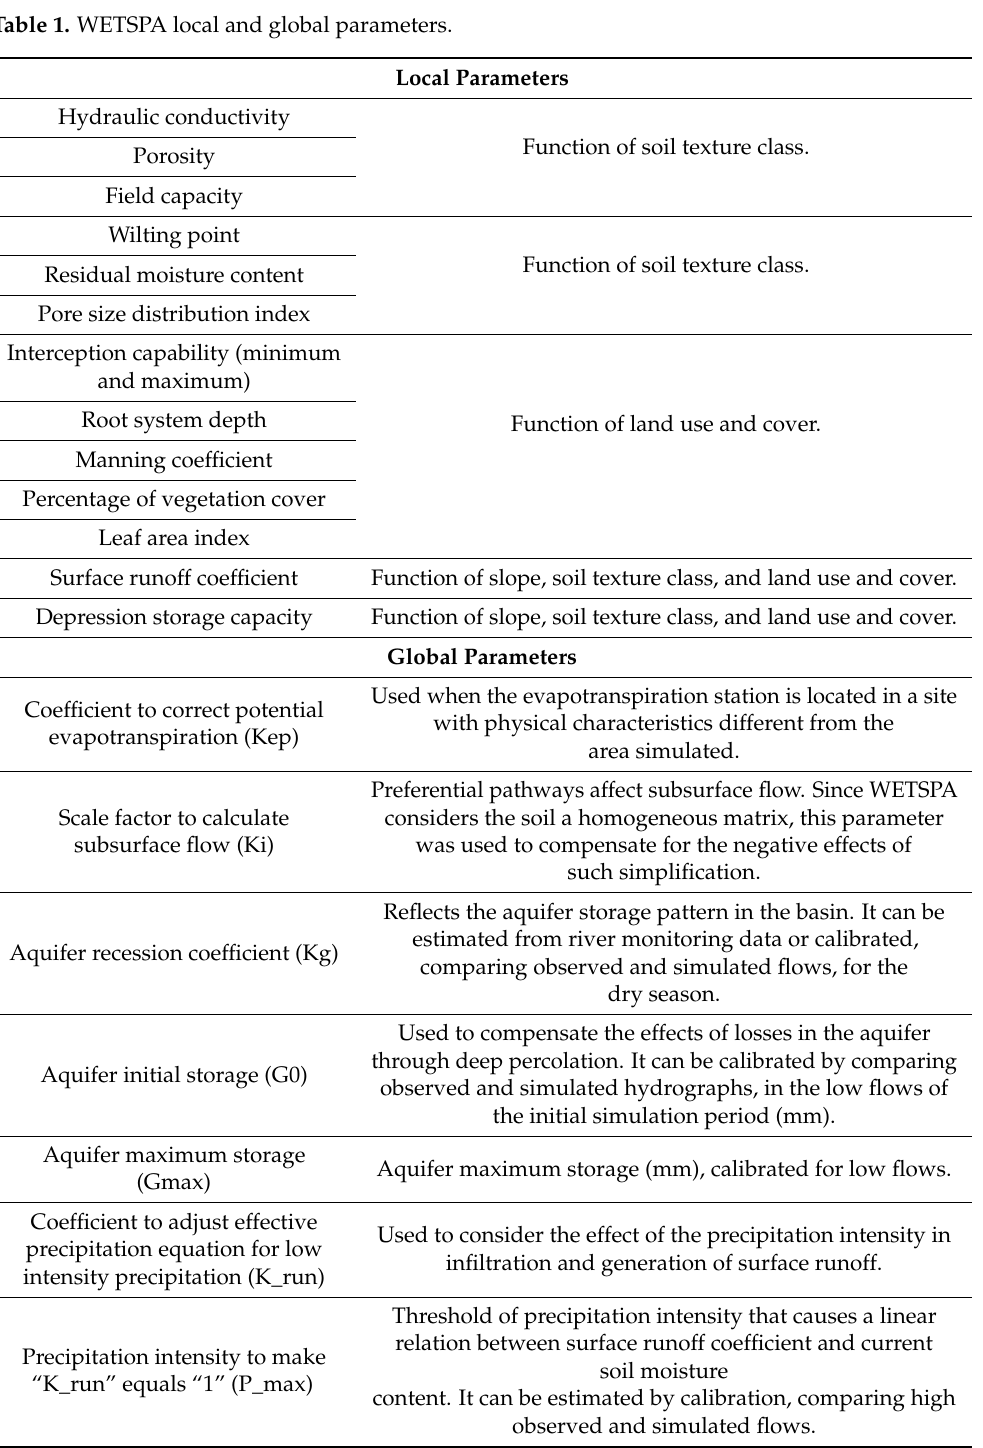
Table 1. WETSPA local and global